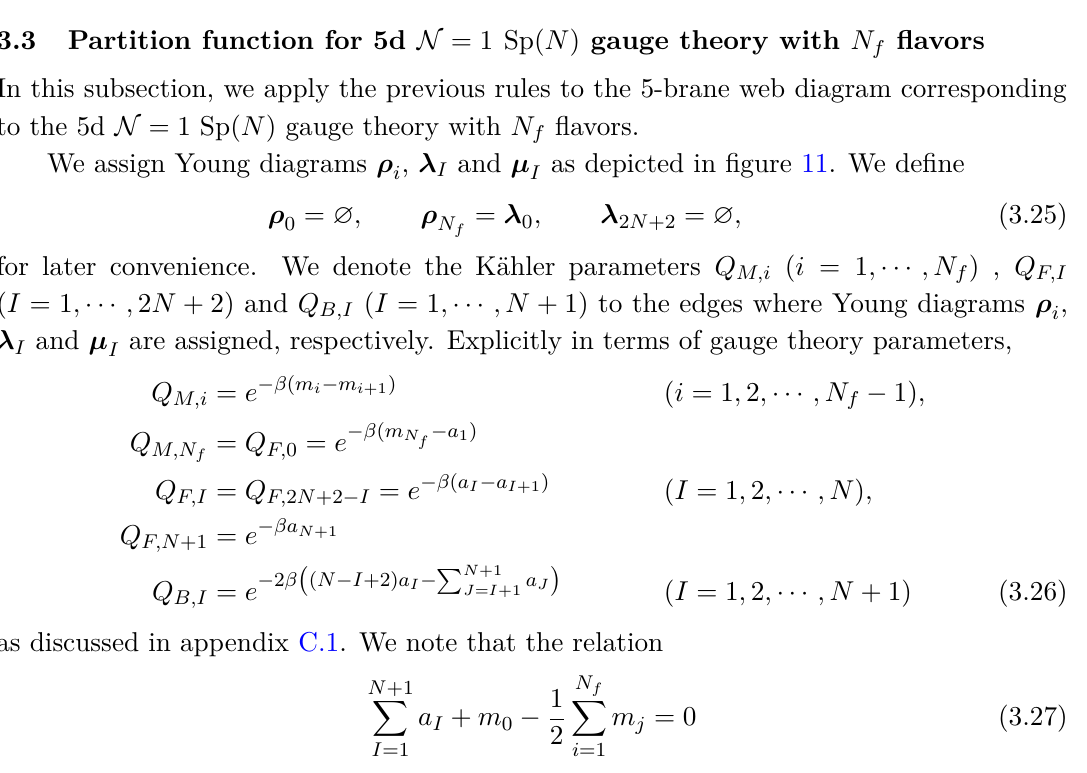
Figure 11 . Assingment of Young